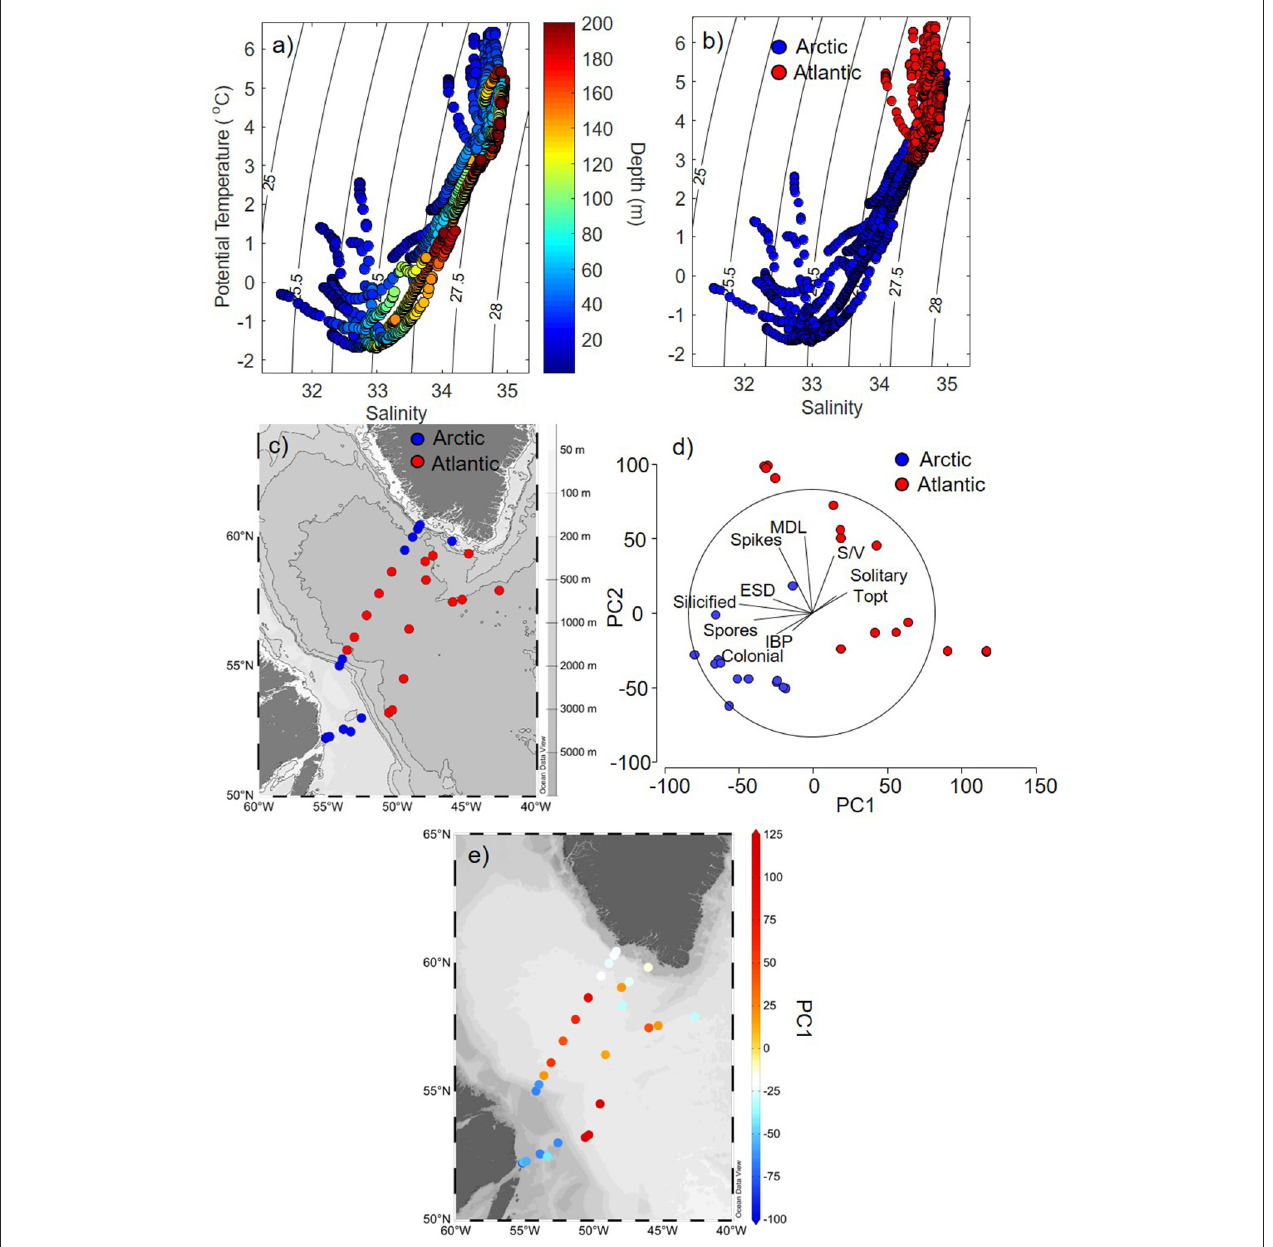
FIGURE 3 | Hydrographic and ecological variability in the Labrador Sea. (a) Potential temperature and salinity vertical profiles (upper 200m) with isopycnal contours as a function of depth and (b) as a function of stations that were characterised as Arctic or Atlantic-influenced. (c) Spatial distribution of stations categorised as belonging to Arctic (blue) or Atlantic-influenced (red) waters in the Labrador Sea. (d) Principal component analysis (PCA) for all diatom trait variables for each station categorised as being influenced by Arctic (blue) and Atlantic (red) waters. (e) Distributions of first axis (PC1, axis x in d ) from the PCA analysis for each station of Labrador Sea, revealing common diatom traits found in Atlantic (red, positive PC1) and Arctic (blue, negative PC1) waters. Abbreviations in figure (d) refers to: ESD, equivalent spherical diameter; MDL, maximum dimension length; S/V, surface area to volume ratio; T opt , optimum temperature for growth; IBP, ice-binding proteins. The maps were generated using the software Ocean Data View (ODV, version 4.7.10, https://odv.awi.de/).